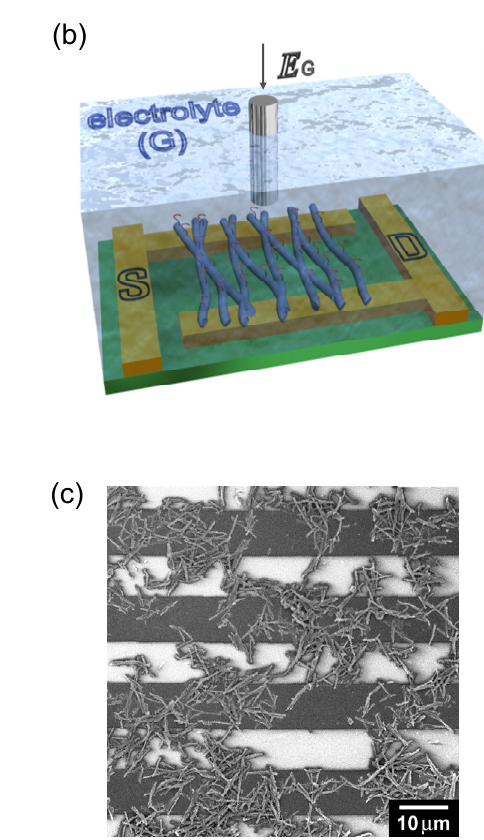
Figure 10. Schematic illustration of ( a ) reaction steps for the fabrication of a sensor platform based on carboxylated PPy nanotubes; and ( b ) a liquid ion-gated FET sensor; ( c ) SEM image of carboxylated PPy nanotubes that are deposited on the interdigitated microelectrode substrate. With permission from [62]; Copyright 2008, Wiley-VCH Verlag GmbH & Co.